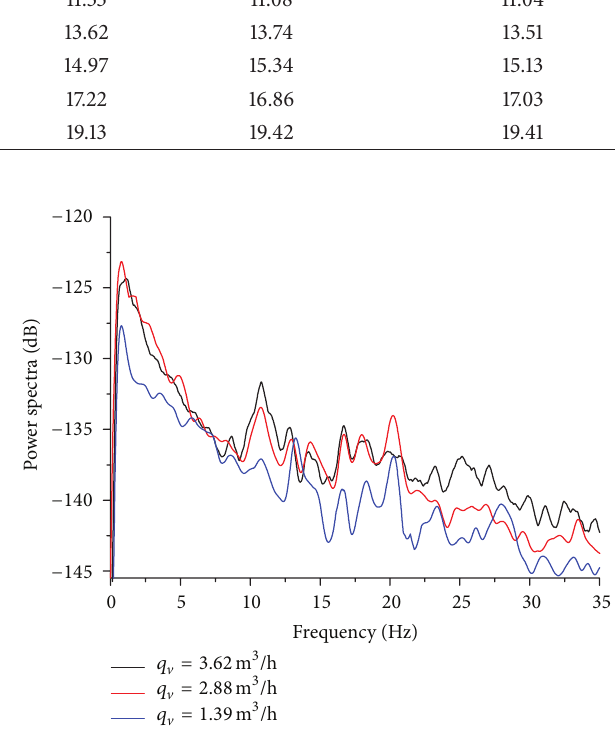
Figure 11: Displacement power spectral density of the fuel rod in through hole case.